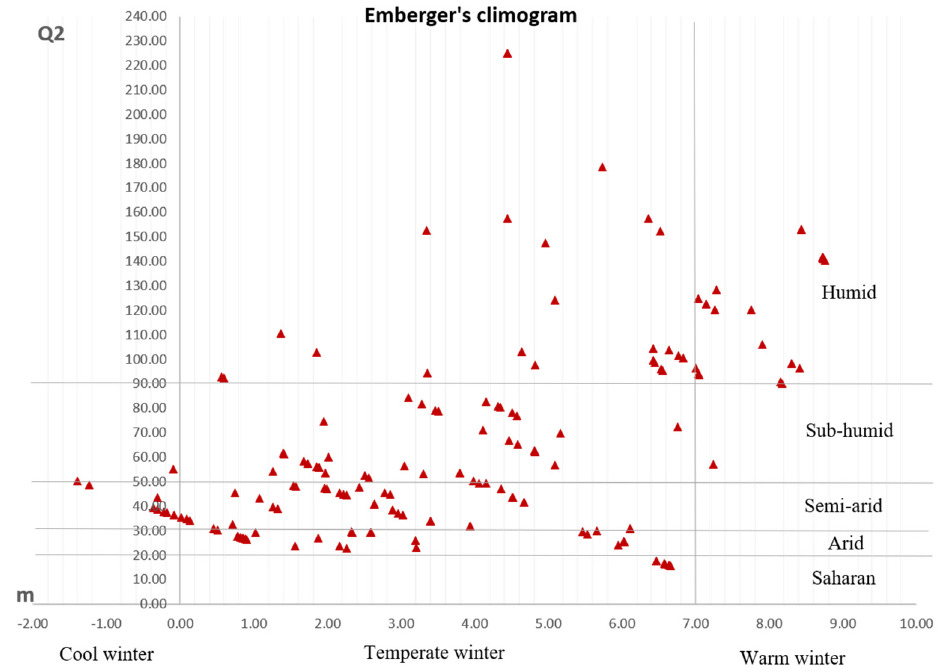
Figure 2. Climogram showing the distribution of the collected wild olive samples according to the Emberger’s coefficient.